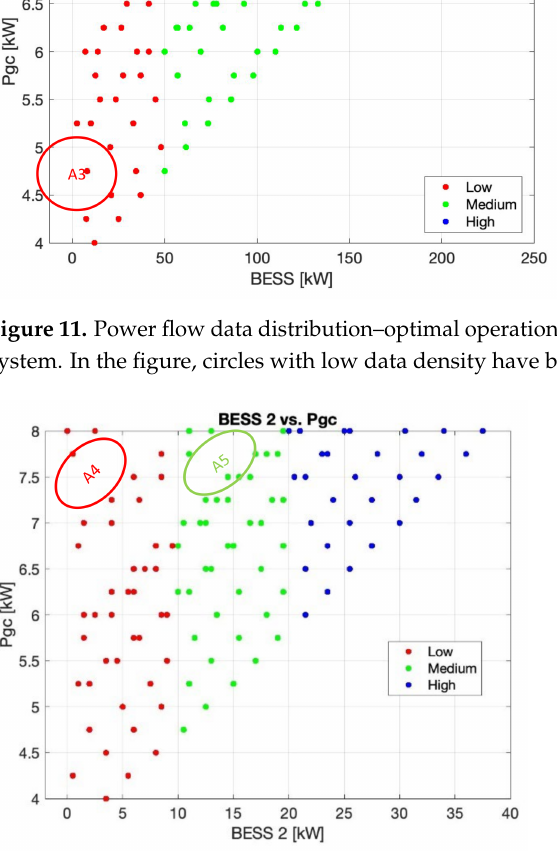
Figure 12. Power flow data distribution–optimal operation of connecting points, BESS 2-only opera- tion system. In the figure, circles with low data density have been marked with